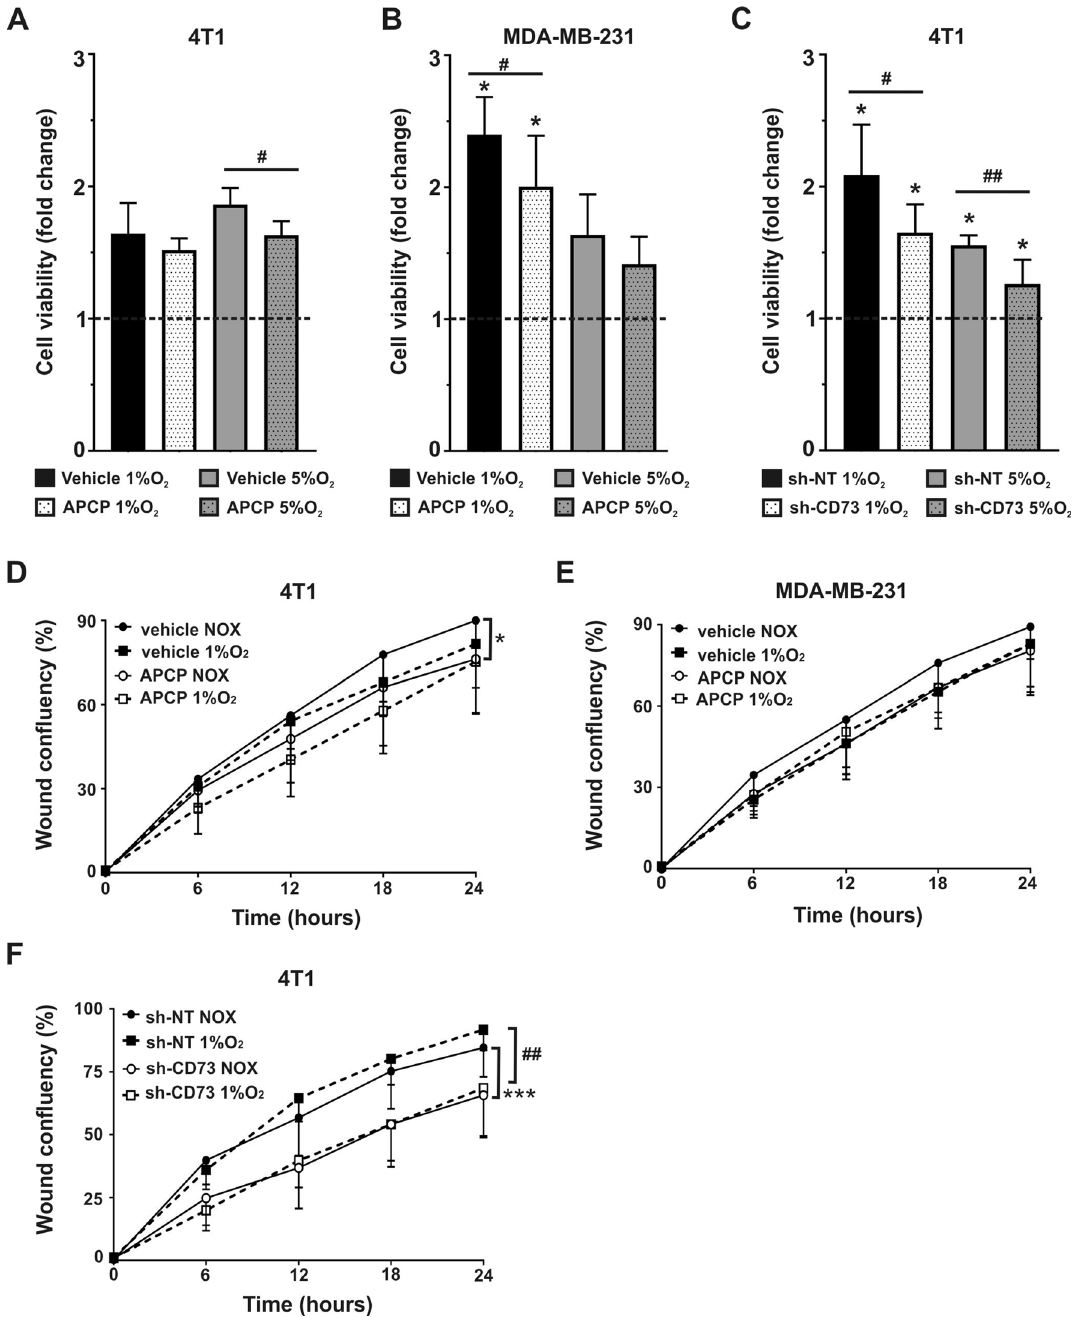
Figure 2. CD73 suppression inhibits cell viability and migration in hypoxia. ( A ) Viability of APCP- or vehicle- treated 4T1 and ( B ) APCP- or vehicle-treated MDA-MB-231 cells, ( C ) sh-NT and sh-CD73 4T1 cells, were measured by WST-8 assays. The bars in ( A – C ) represent fold-change in viability, as compared with normoxia (set to 1 and indicated with the dotted line). The bars represent mean ± SD, n = 3. *P < 0.05 vs the same cells in normoxia. # P < 0.05, ## P < 0.01; sh-CD73 cells vs. sh-NT cells, or APCP vs. vehicle, by one-way ANOVA with a Dunnett post-test. Scratch wound assay with ( D ) APCP- or vehicle-treated 4T1, ( E ) APCP-or vehicle-treated MDA-MB-231 cells, and ( F ) sh-NT and sh-CD73 4T1 cells, in normoxia or 1% O 2 for 24 h. Wound confluences were analyzed using IncuCyte 2018B software (Essen Bioscience). The results are expressed as mean ± SD, n = 3. *P < 0.05; ***P < 0.001; sh-CD73 or APCP-treated 4T1 cells vs representative controls in normoxia; or ## P < 0.01 in hypoxia, by one-way ANOVA with a Dunnett